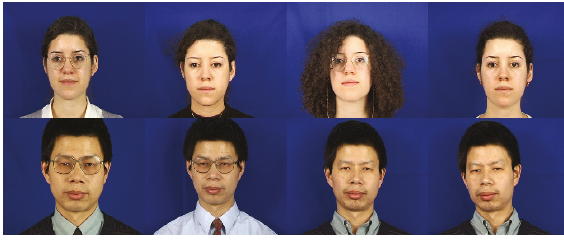
Figure 9: Sample images from the image part of the XM2VTS